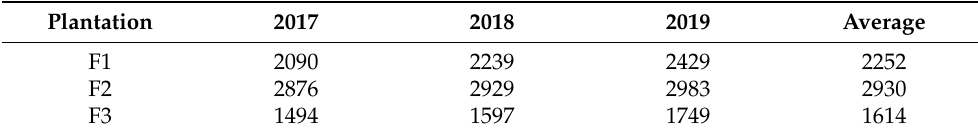
Table 5. Amount of irrigation water used per year (t ha − 1